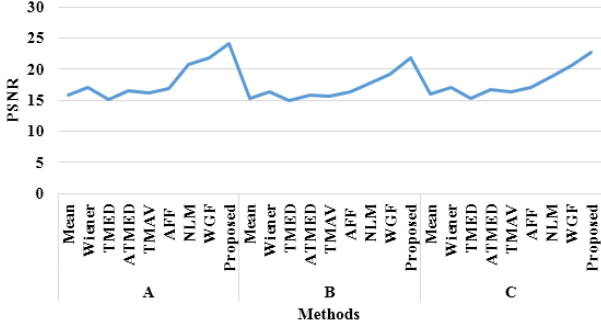
Figure 10: Graphical comparison of PSNR value (0.03 Level Gaussian noise)